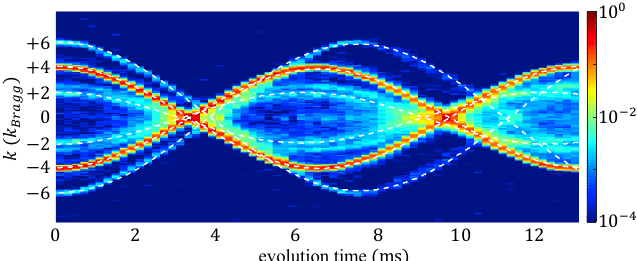
Figure 4: Oscillations in the first period (time resolution of measurements ∆ t = 0.2ms). The distributions are shown in log scale with the maximum normal- ized to unity. The oscillation periods for ± 2 k to be 12ms, 13.2ms, 15.2ms,